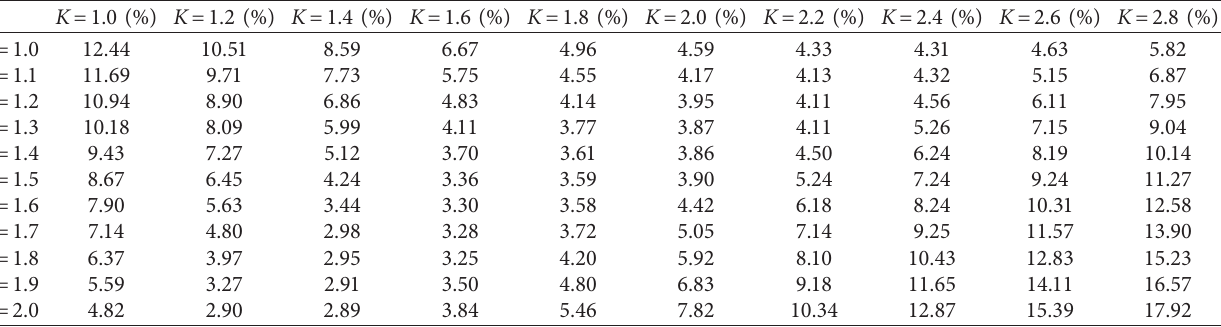
Figure 11: Variation of initial dilatancy angle with cycles at different c values. Table 2: Error estimation table of friction coefficient estimated value and test value.